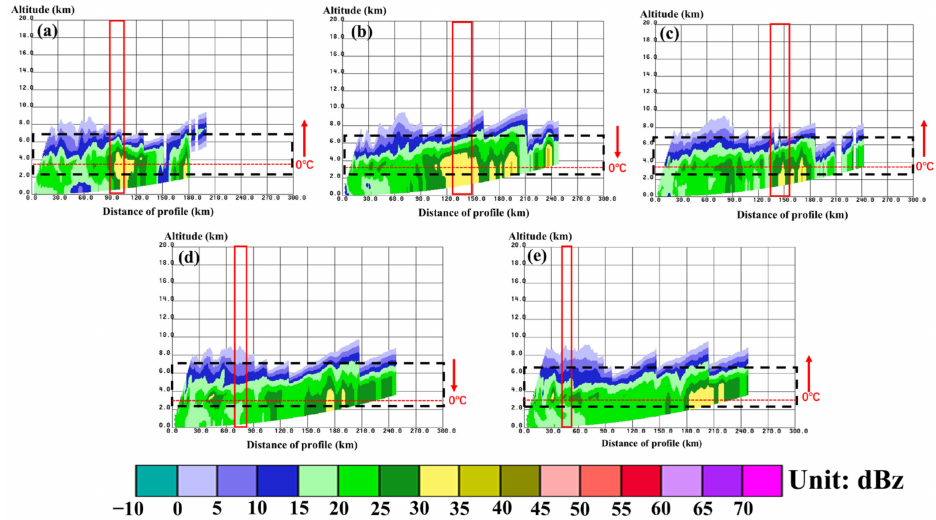
Figure 6. 22 May 2017, ( a ) 15:42 of V1, ( b ) 16:12 of V2, ( c ) 16:36 of V3, ( d ) 17:30 of V4, ( e ) 17:54 of V5. The red rectangle box is the aircraft detection